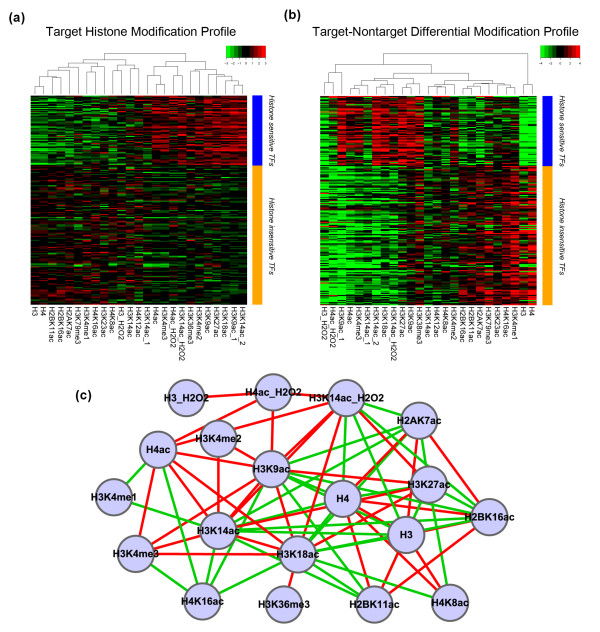
Target histone modification profiles and target-non-target differential modification profiles of TFs. (a) Target histone modification profiles comprising different normalized histone modification signals (columns) of TFs (rows). A target histone modification profile is the averaged histone modification signals of the TF's targets. TFs are clustered into histone-sensitive (blue bar) and -insensitive TFs (orange bar) using their target histone modification profiles. Histone-sensitive TFs have stronger histone modification signals. (b) Target-non-target differential modification profiles of TFs showing the discriminating power (t-statistic) of histone modifications to TF targets and non-targets. TFs are ordered the same as in (a). Histone-sensitive and -insensitive TFs have distinct differential modification profiles, indicating preferential histone modifications of TFs targets. (c) Correlation network of histone modifications in terms of TF differential modification profiles. Histone modification pairs with a correlation coefficient larger than 0.5 (red edges) or smaller than -0.5 (green edges) are connected. The network shows a high level of redundancy of histone modifications in differential modification profiles.